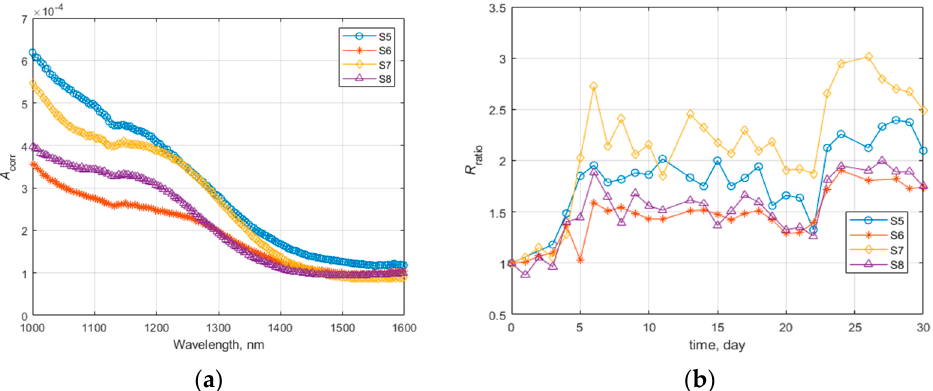
Figure 6. ( a ) Autocorrelation spectra (main diagonal of the 2D-COS synchronous spectrum) of samples without the Ag electrode (S5, S6, S7 and S8), excited from the foil side; the spectral region for the calculation of the parameter R ratio ( t ) was: R ratio ( t ) = R ( t , 1000 nm)/ R ( t , 1550 nm). ( b ) The R ratio vs. time.